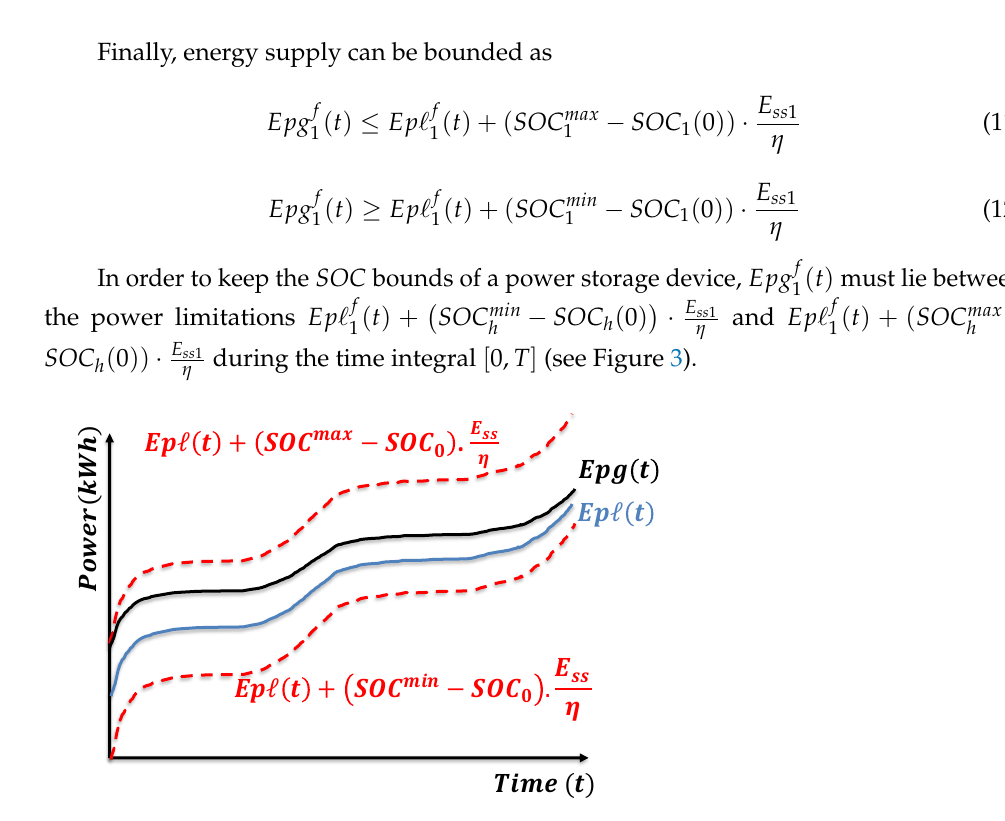
Figure 3. In order to keep SOC limitations, Epg must stay between two dotted lines determined by Ep (cid:96) + SOC min and Ep (cid:96) + SOC max